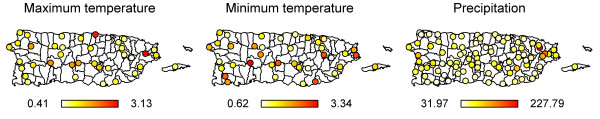
Cross-validation error by station location. Mean RMSE for Tmax (linear model, °C), Tmin (linear model, °C), and precipitation (Bayesian kriging model, mm) at 1,000 meter resolution.